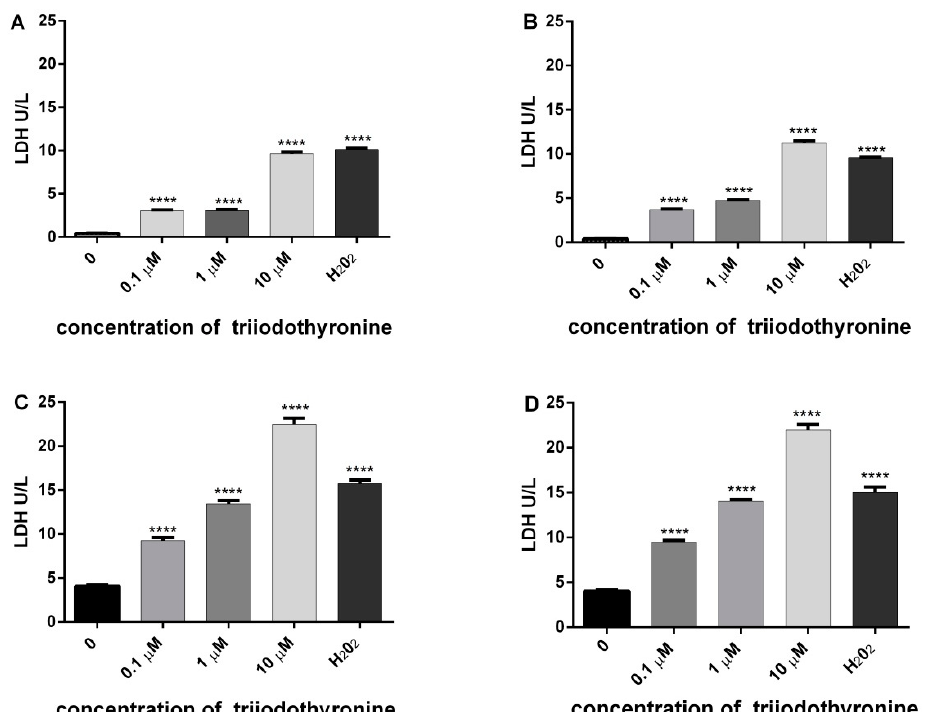
Figure 4. Level of lactate dehydrogenase (LDH) release as an indicator of cell cytotoxicity in lym- phocytes of ( A ) normal, ( B ) obese, ( C ) prediabetics, and ( D ) T 2 DM, treated with various concentra- tions of triiodothyronine and positive control (H 2 O 2 ). The results are presented as means ± SEM. **** p < 0.0001 in comparison to the negative control group, in one-way ANOVA by Dunnett test.